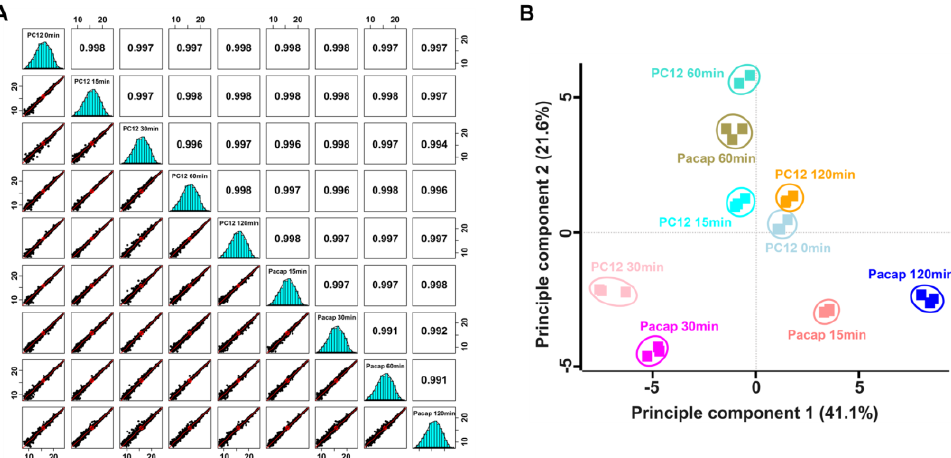
(FC) differences, Supplementary Table S1) and 830 (with >1.25-fold change (FC) differences, Supplementary Table S2) significantly modulated proteins.